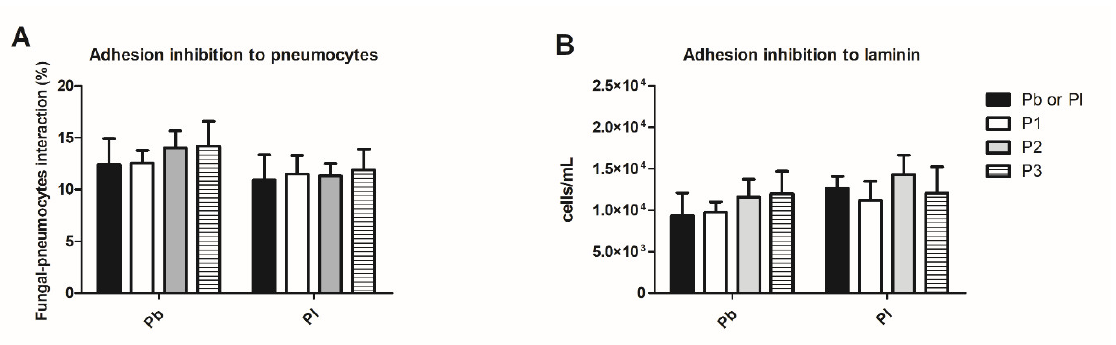
Figure A1. Effect of 14-3-3 peptides treatment in the adhesion to pneumocytes ( A ) or laminin ( B ). Data are expressed as mean ± standard deviation of eight biological replicates and three independent experiments using Kruskal–Wallis and Dunn’s ( p <